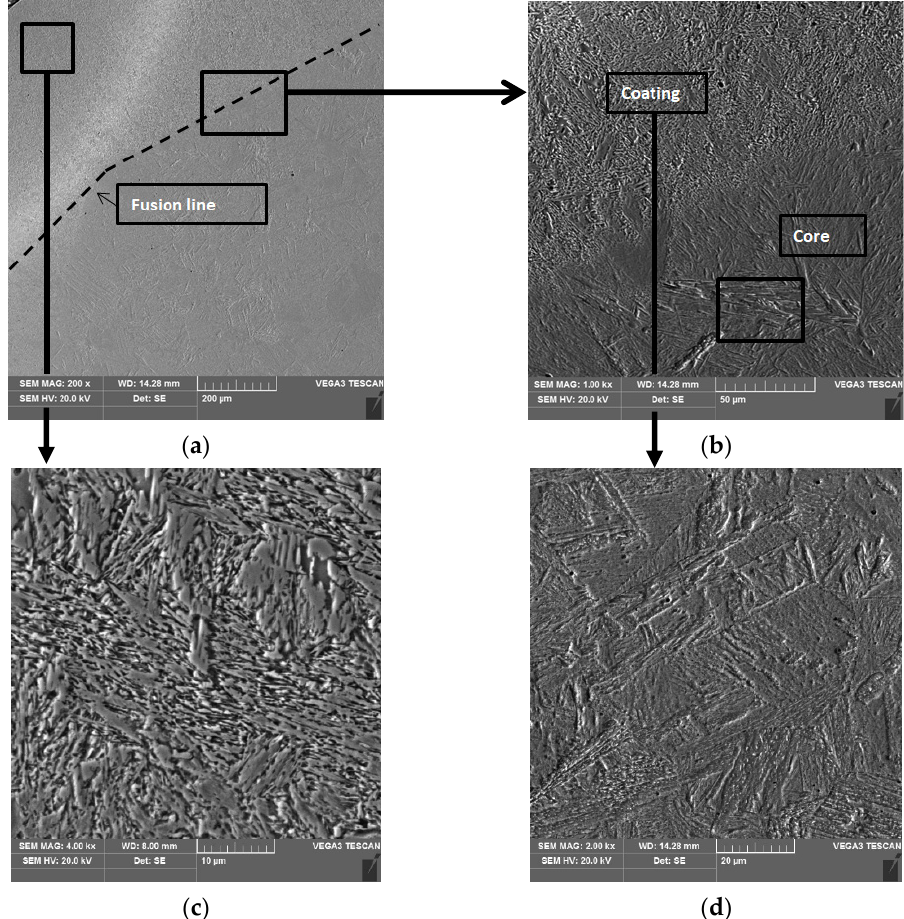
Figure 10. Microstructure of a turbocharger shaft journal cross-section after single-layer hardfacing. Transition zone microstructure, coating-core ( a ), detail from ( a ), coating-core ( b ), coating microstructure ( c ), core microstructure ( d ).